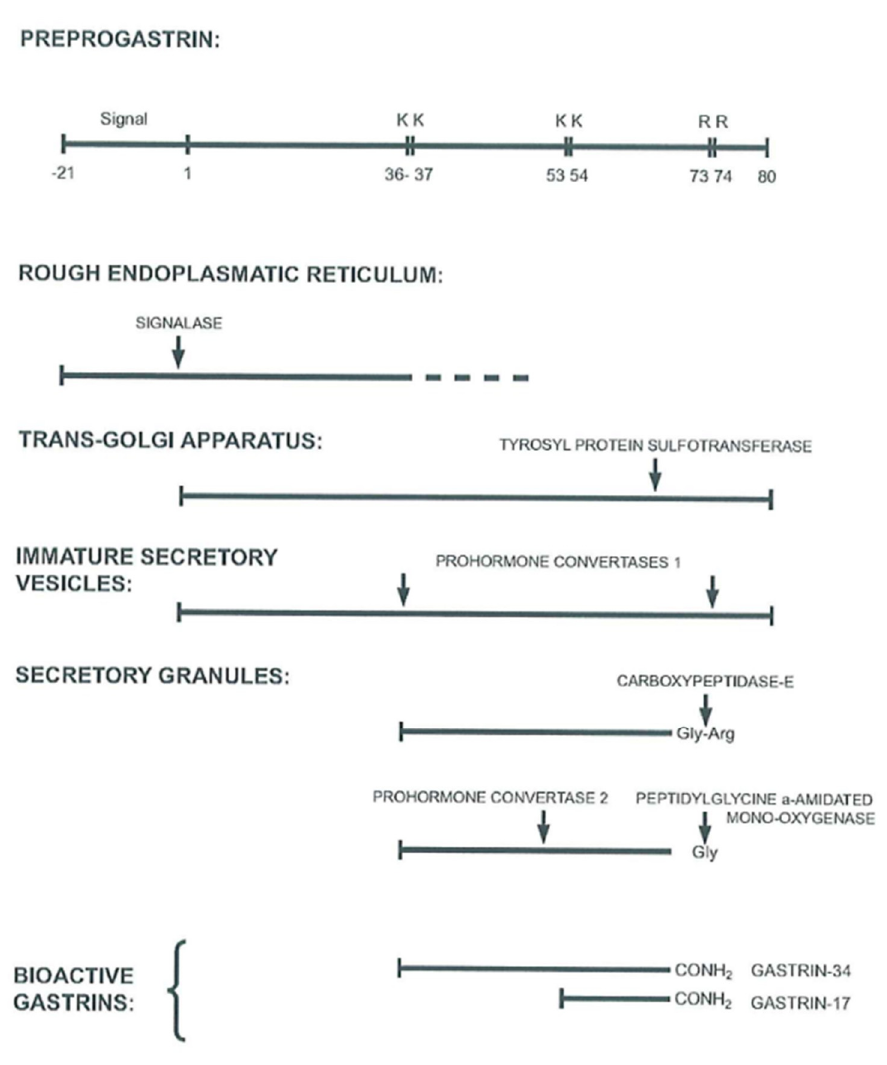
Figure 2. Scheme of processing steps for progastrin to release the two major bioactive gastrins, gastrin-17 and gastrin-34. Both forms are synthetized partly tyrosyl-sulfated. The endoproteolytic cleavages of progastrin are performed by prohormone convertases 1/3 and 2 [37,39].